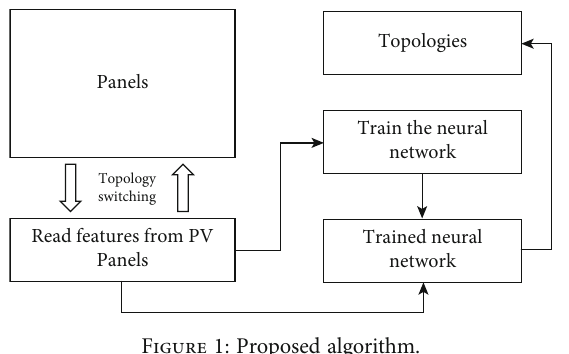
Figure 1: Proposed